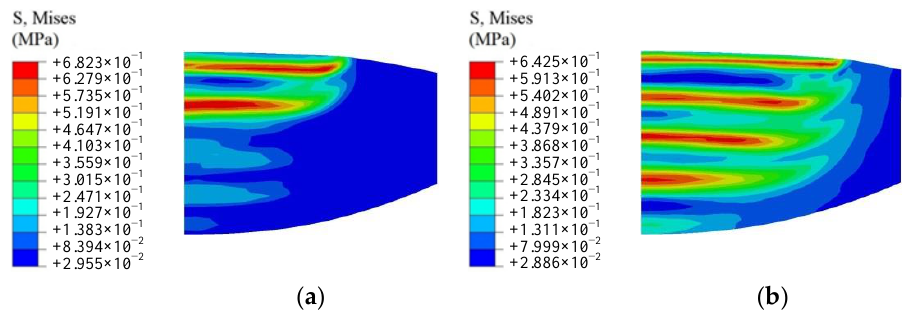
Figure 11. Stress distribution of ChG aspherical lens molding: ( a ) early stage and ( b ) later stage.